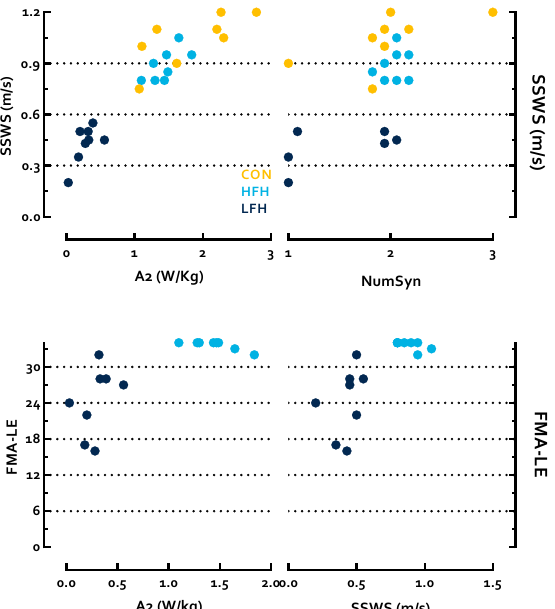
Figure 1. Top left Individual plots of A2 and SSWS, (top right) NumSyn and SSWS, (bottom left) A2 and the FMA-LE, and (bottom right) SSWS and the FMA-LE for CON (gold), HFH (light blue), and LFH (dark